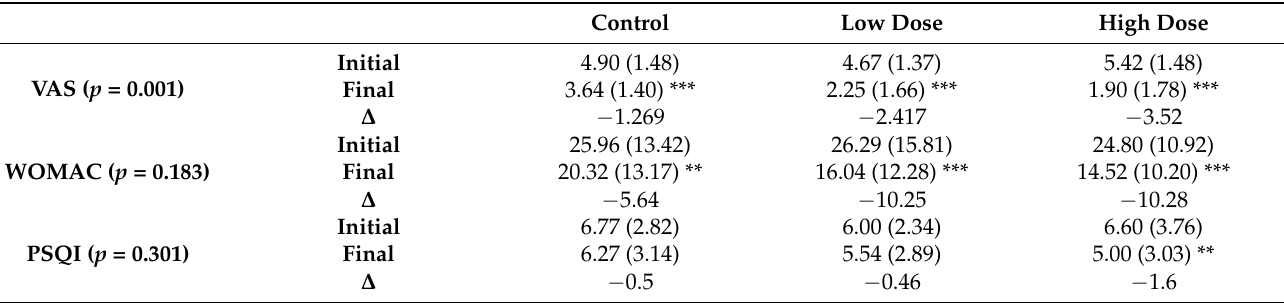
Table 2. Visual analogue scale (VAS) for perceived pain, functional capacity by means of the WOMAC test, and Pittsburgh Sleep Quality Index (PSQI) for each of the visits and doses. ∆ represents the increment from the start to the end of this trial. Significance level for the differences between values at the beginning and end of this